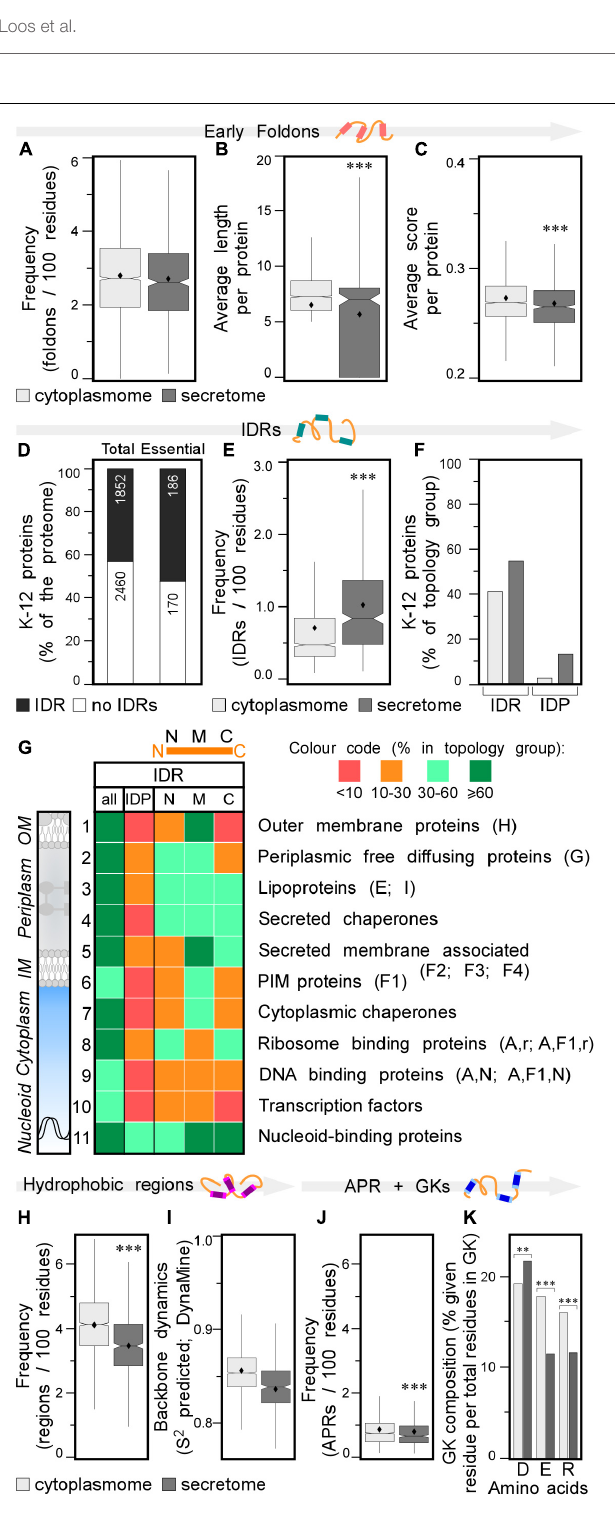
FIGURE 3 | Local features of the K-12 proteome. (A) Frequency of early foldons in proteins (foldons per 100 amino acids). (B) Average length of early foldons per proteins. (C) Average score of early foldons per proteins. (D) Prevalence of proteins with IDRs in K-12 (numbers of proteins are indicated in the bar). (E) Frequency of IDRs in proteins (IDRs per 100 amino acids). (F) Percentage of proteins having IDRs (left) or being IDPs (right). (G) Heat-map of overall IDR occurrence and in N terminal (N), middle (M), C